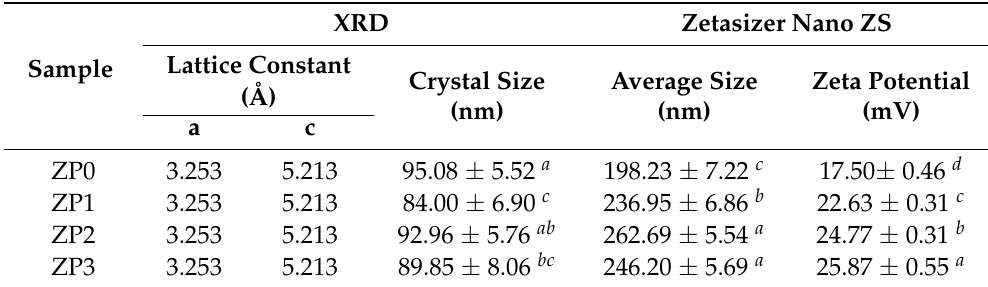
Table 1. Summaries of crystal information and surface charge of ZnO and functionalized ZnO sam- ples.